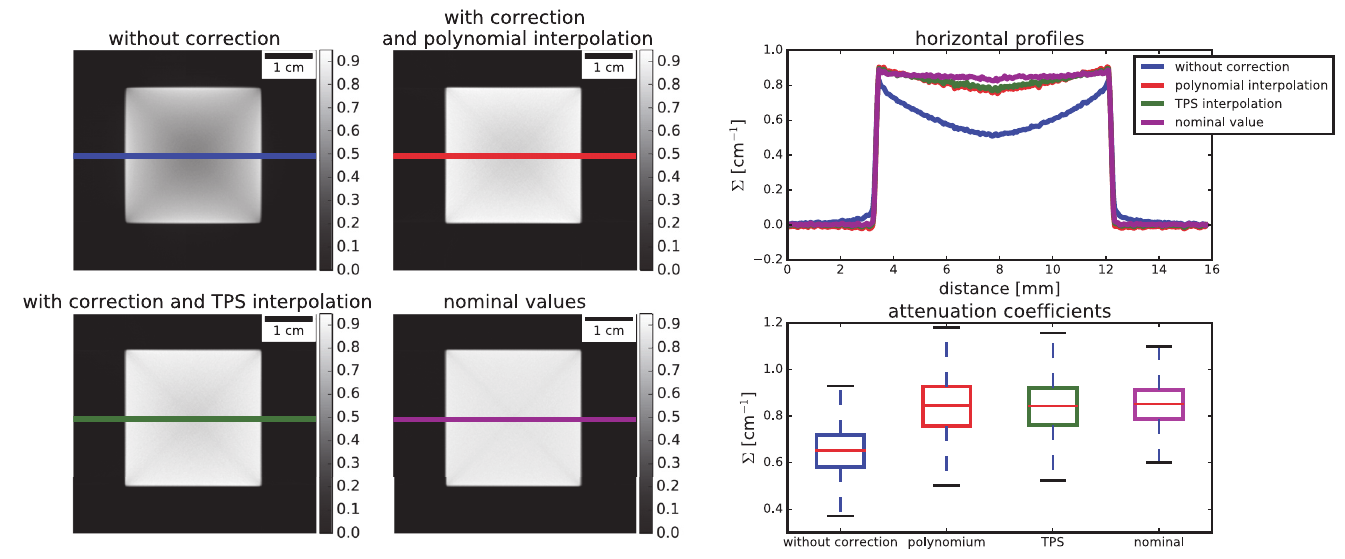
Fig 14. Results on CT reconstruction for the simulated